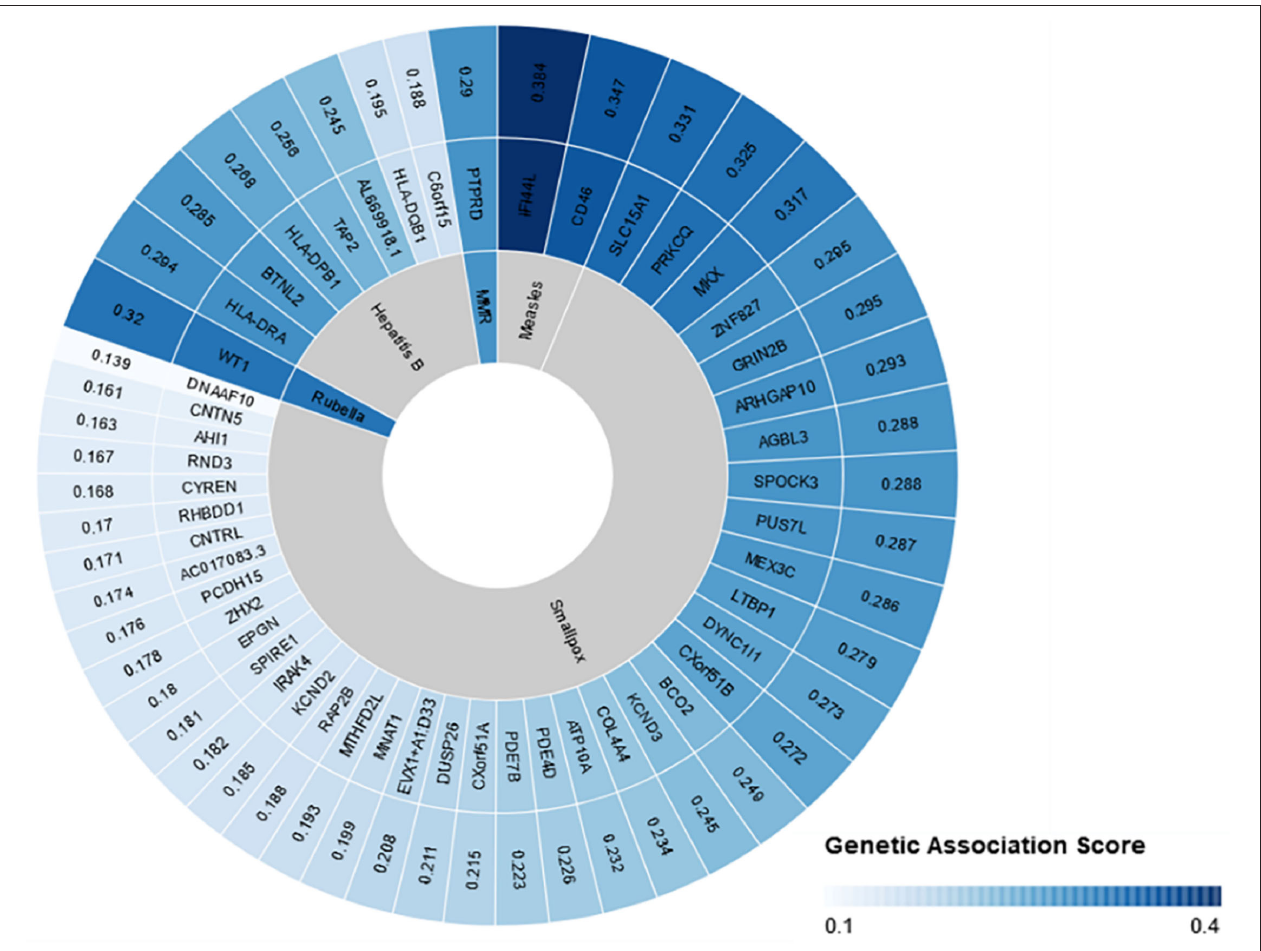
FIGURE 3 | Open Targets genetics association scores for genes linked to vaccine response. Open target platform was used to search for all the associations under “response to vaccine” phenotype. The top 50 associations are plotted with the association score, the name of the corresponding gene, and the pathogen name to which vaccine was given. This figure was generated using